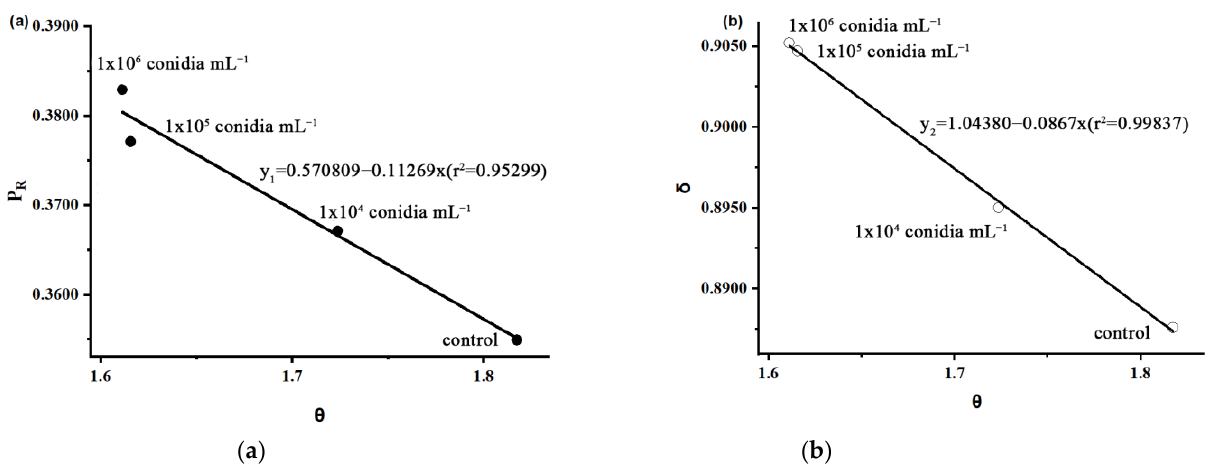
Figure 9. The lethal effect and parasitic effect of S. guani on the larvae of M. alternatus under different concentrations of B. bassiana spore suspension: ( a ) time-lethal effect; ( b ) time antagonism.